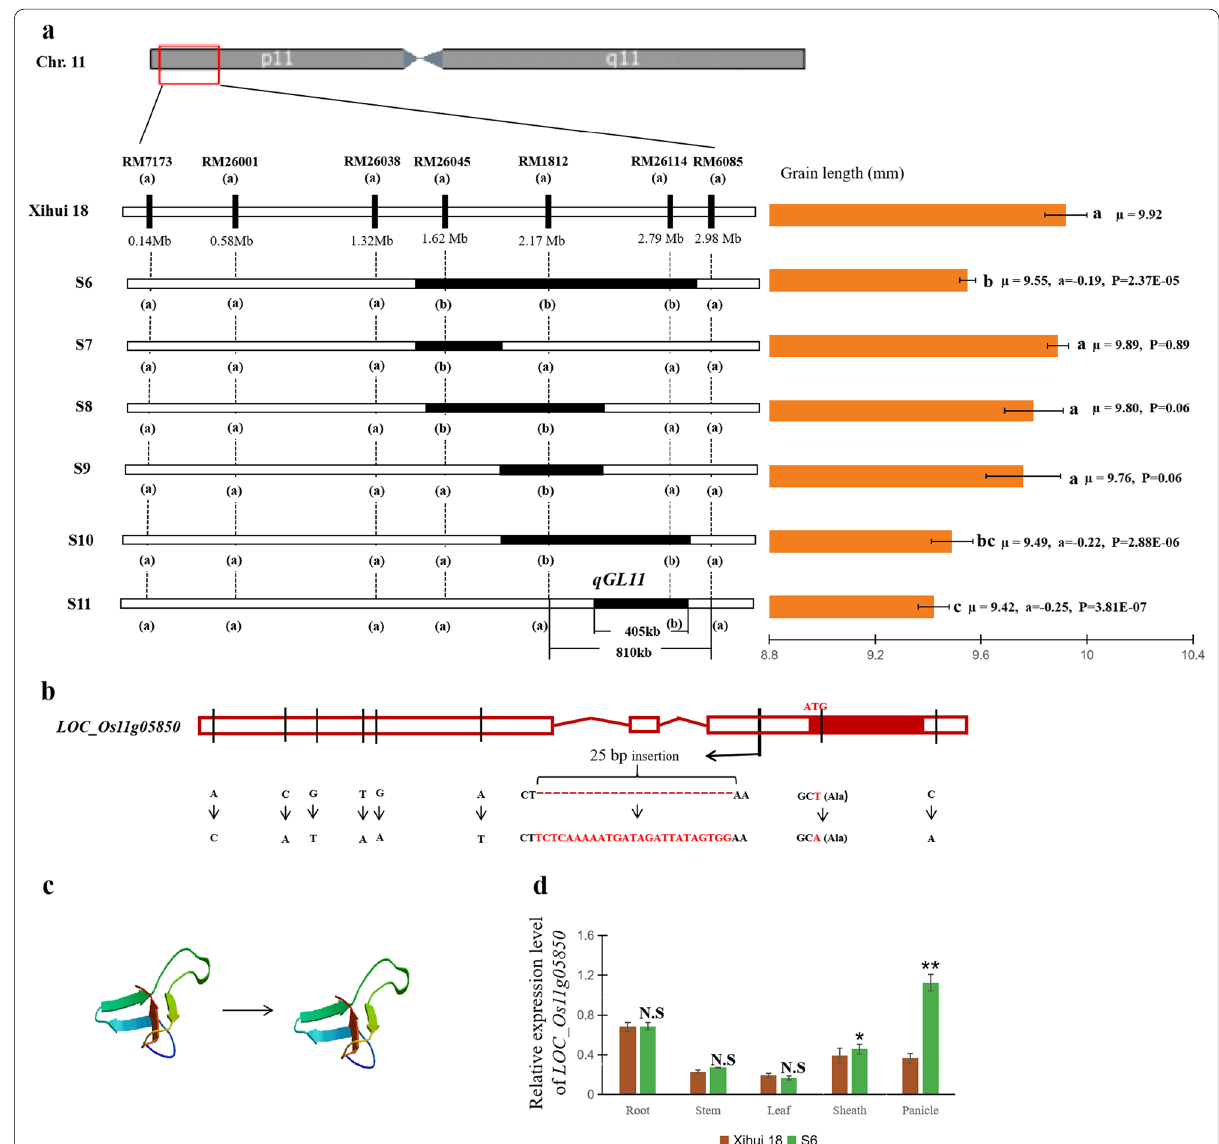
Fig. 5 Substitution mapping, sequence analysis, and relative expression level of qGL11 in Xihui 18 versus S6. a Substitution mapping of qGL11 . Black regions indicate the estimated length of the substitution segment. b DNA sequence of CycT1;3 in S6 compared with Xihui 18. In the candidate gene sequence, the red box represents the coding sequence, the white boxes represent the 5 ′ UTR and 3 ′ UTR, the solid red lines represent introns, the black line in the gene sequence represents the mutation site, and the arrow represents a sequence change from Xihui18 to S6. c Protein structure of CycT1;3 predicted by SWISS-MODEL. d Relative expression levels of the candidate gene CycT1;3 in root, stem, leaf, sheath, and panicle tissue of Xihui 18 versus